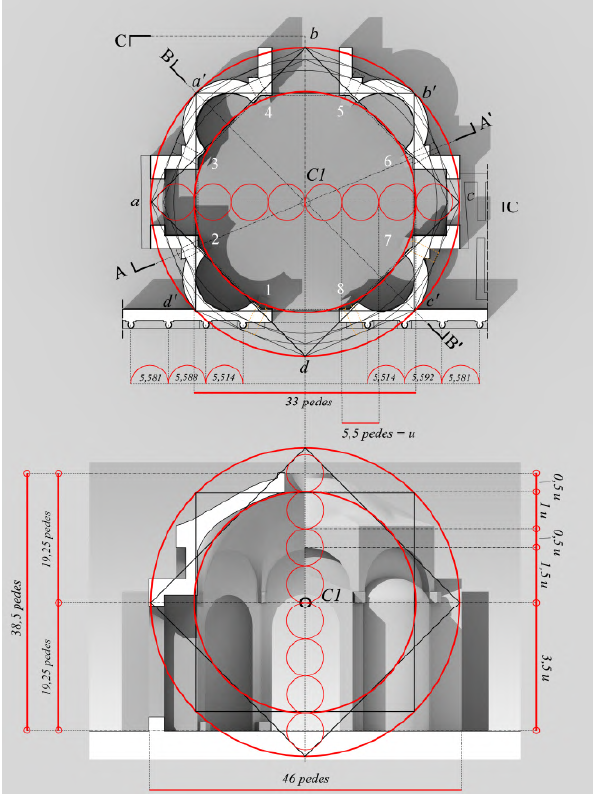
Figure 13. Even if characterized by different proportions, the Vestibule design results consistent with the impost line of the nearby Triclinium and the grid-based design of the portico.